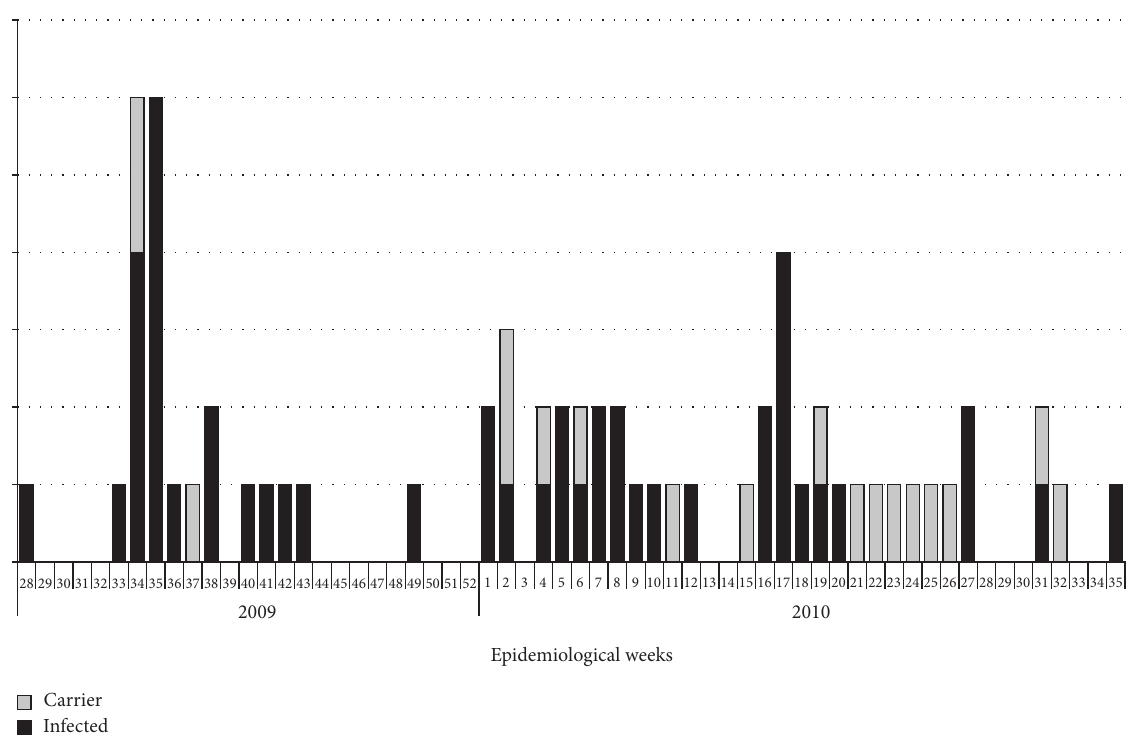
Figure 1: Epidemic curve expressing the incidence of cases (carriers and infected patients) involved in the A. baumannii outbreak over time (epidemiologic weeks). After the 36th week of 2010, no new cases were